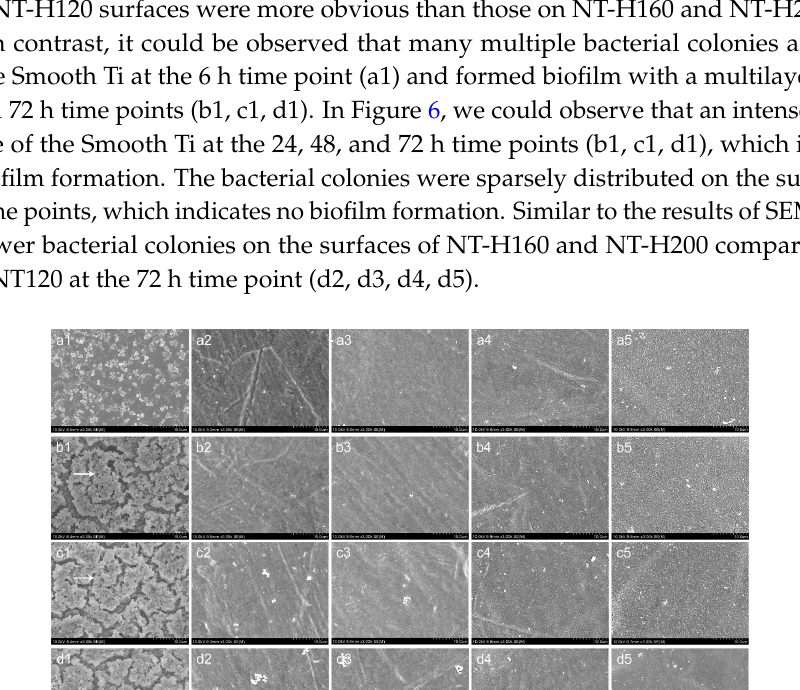
Figure 4. Biofilm formation of the three bacterial strains. ( A ) ATCC 43300; ( B ) ATCC 35984; ( C ) Staphylococcus aureus 376; and ( D ) S. epidermidis 389 on Smooth Ti and NT ‐ H surfaces at 24 h, 48 h, and 72 h, as detected by the tissue culture plate method. * denotes a significant difference compared to Smooth Ti ( P < 0.01). # denotes a significant difference compared to NT ‐ H80 and NT ‐ H120 ( P < 0.01).